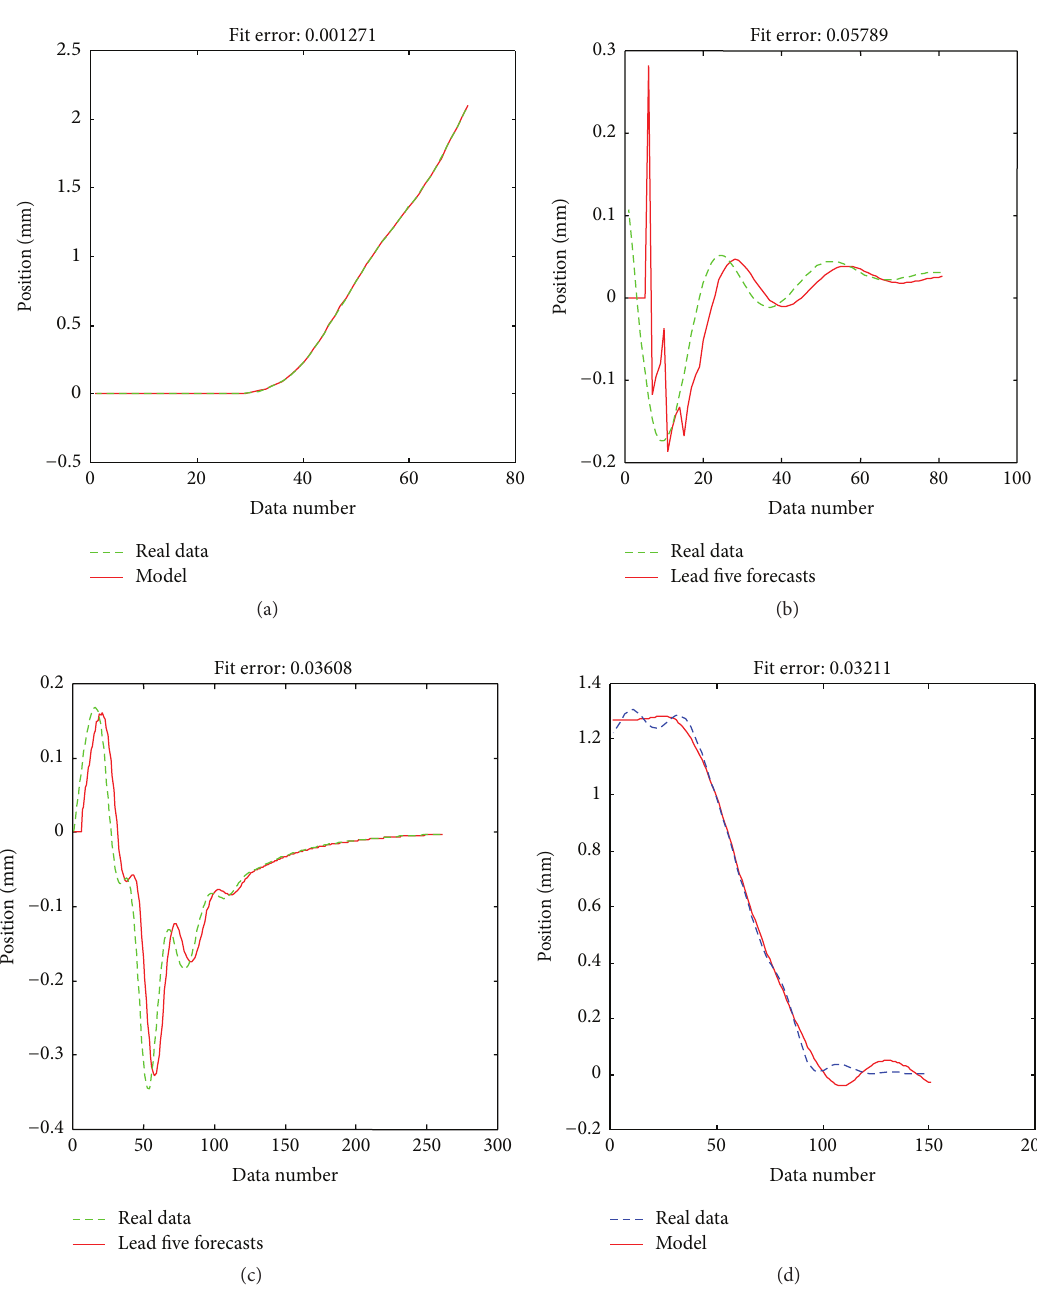
(3) Increase the friction of the guide to rapidly attenuate